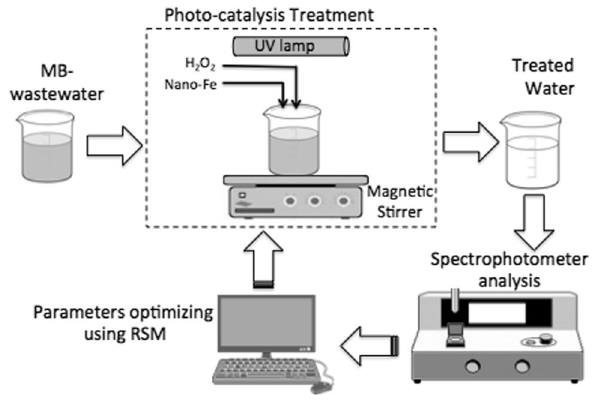
Fig. 1 Sketch of the experimental representation Table 1 Range and levels of natural and corresponded coded vari- ables for RSM Variable Symbols